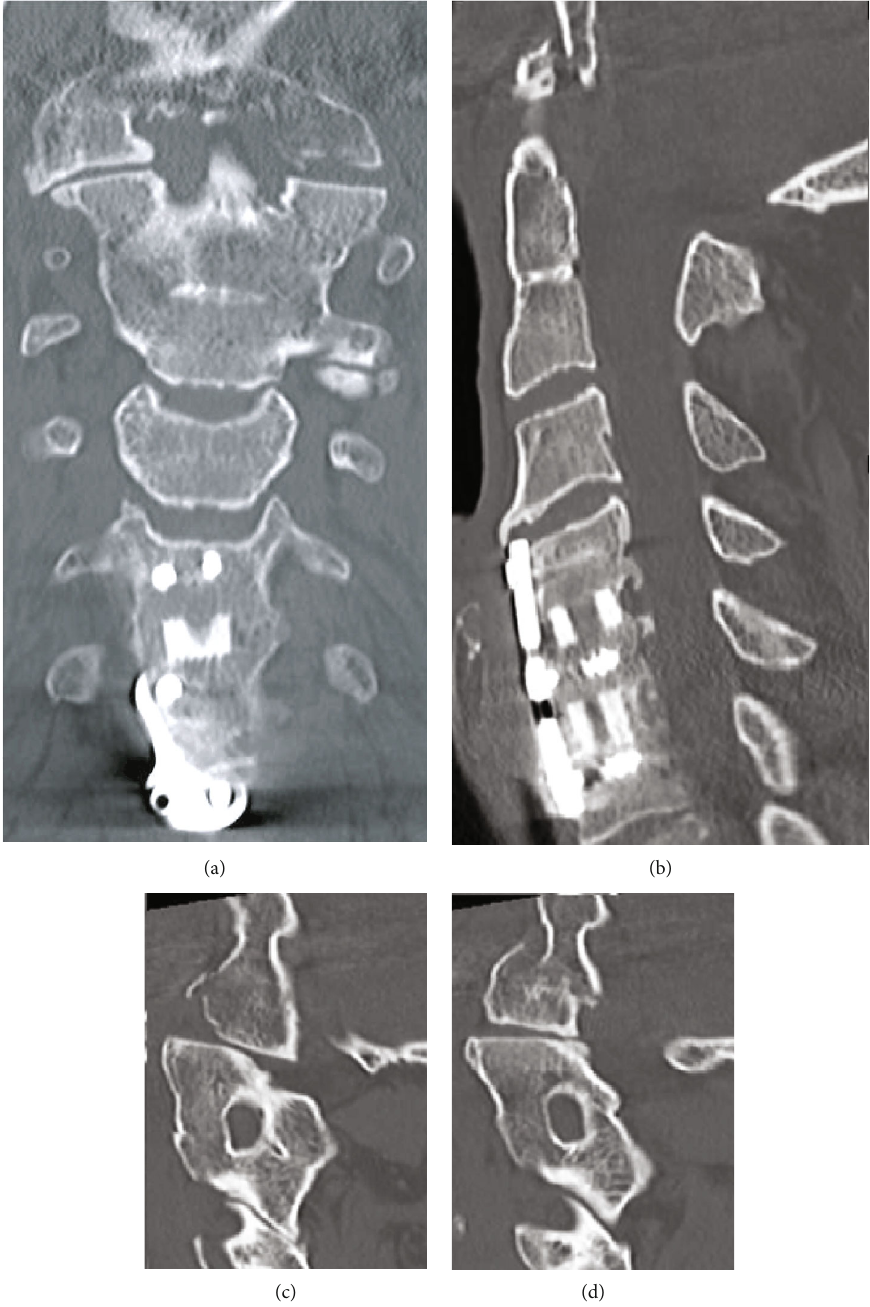
Figure 1: Case 1: cervical CT. (a) Complete C1 assimilation, C2-C3 congenital fusion block. (b) Previous C5-C7 ACDF. The C1 anterior ring is fracture displaced and positioned anterior to the clivus. The C1 posterior arch is fused to the occiput. (c) Left atlantoaxial subluxation. (d) Right condyle C1 lateral mass fracture (Figure 1). Cervical computed tomography angiography (CTA) showed in the right vertebral artery, as it courses through the fracture occipito-C1 posterior arch assimilation, a focal luminal narrowing of 50% approximately (Bi ffl type 2) caused by blunt trauma mechanism.